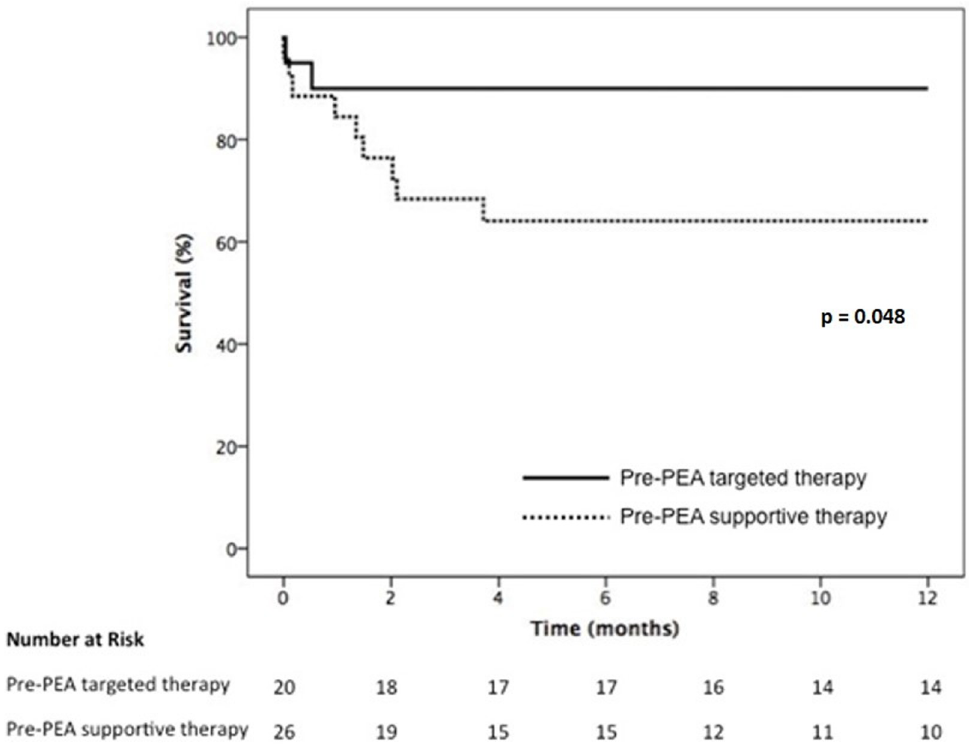
Fig 3. One-year survival according to the use of pre-PEA therapy in patients with low cardiac output ( < 3.75 L ∕ min).